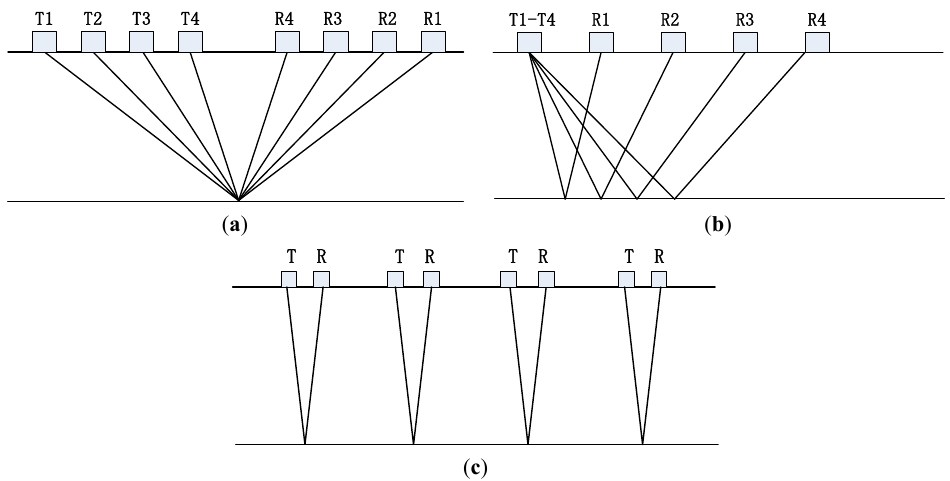
Figure 2. Schematic diagram of CMP method ( a ), WARR method ( b ) and FO method ( c ). (“T” means transmitting antenna, and “R” means receiving antenna. The bottom lines represent an interface or a target with a large electrical difference in the soil).